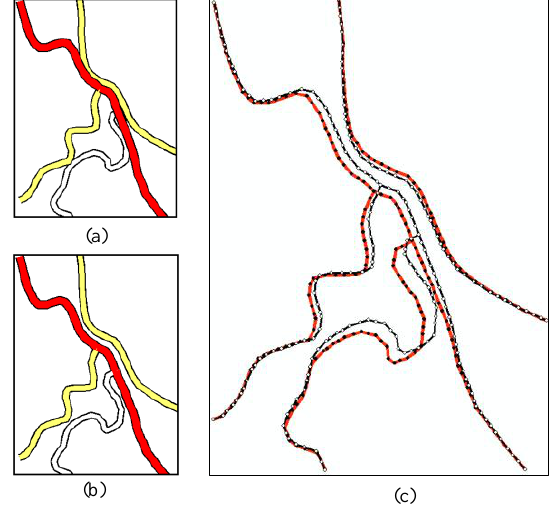
Figure 4. Result of displacement: (a) Initial roads (1:1000k), (b) Displaced road (1:1000k), and (c) Comparing the Initial and final state Building dataset (scale 1:10k), contains 27 buildings in a street block. On the map, buildings are represented by area symbols with solid outline (0.1mm), streets are represented by double line symbols (1.2mm). Figure 5 demonstrates the intermediate states of CDT construction, skeleton extraction, proximity graph construction, conflict detection and force calculation in the 1st iteration. After 8 times iterations, all of the conflicts were resolved. Figure 6 shows the final result and the comparison of the initial and the final state. We can find that the result is much more legible than the original map, and the spatial relationships and structures of the building block are kept very well.